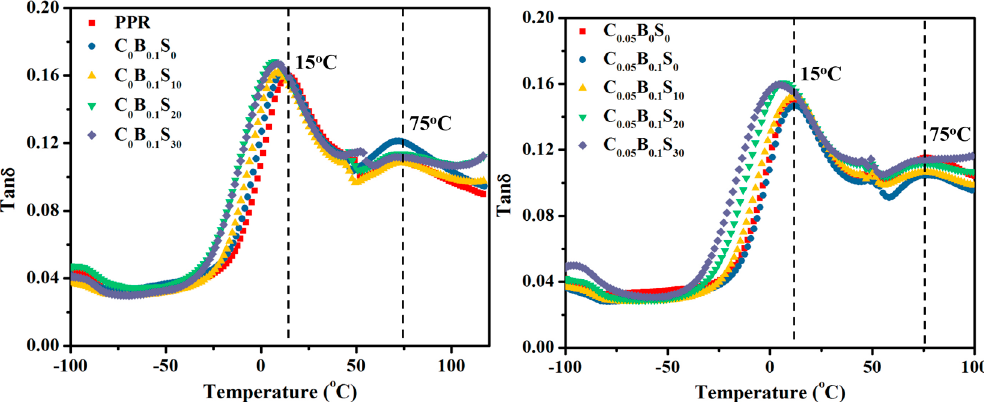
Figure 9. The loss factor (tan δ ) of the PPR and its blends as a function of temperature.